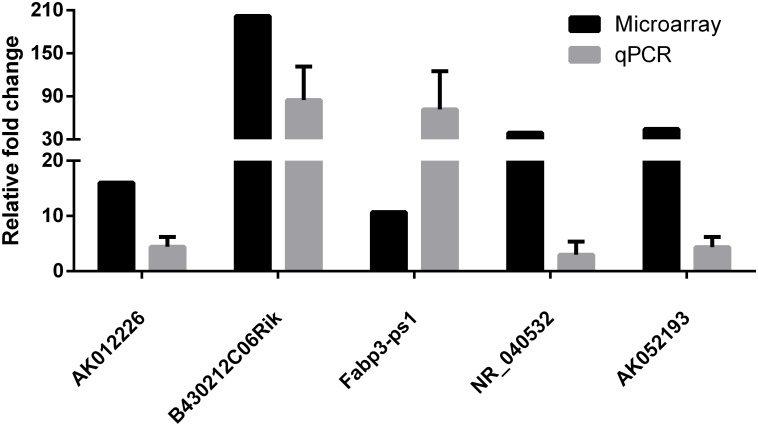
Comparison of microarray data and real-time quantitative polymerase chain reaction (qPCR) data for five selected differentially expressed lncRNAs in liver samples between NAFLD mice and control mice. The qPCR results are generally consistent with the microarray data. The results are the means of three independent experiments. The values in bar graphs are means ± SD.